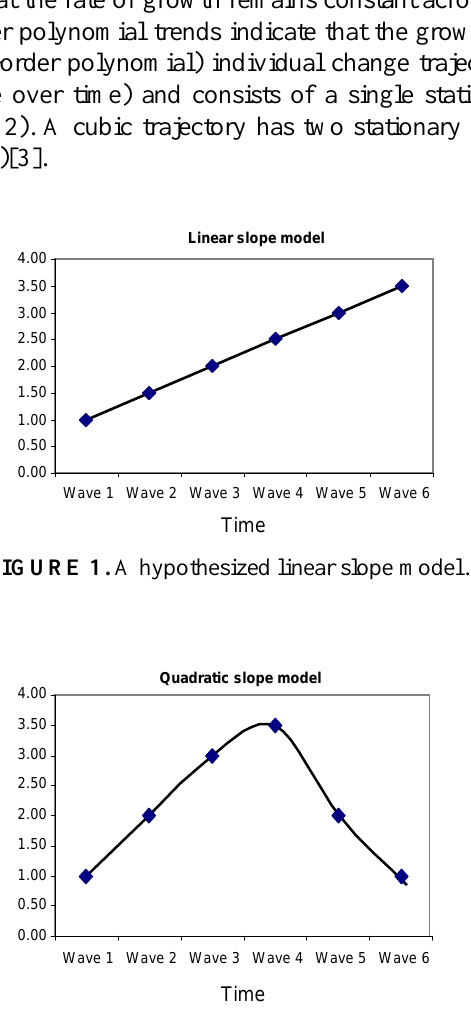
FIGURE 2 . A hypothesized quadratic slope